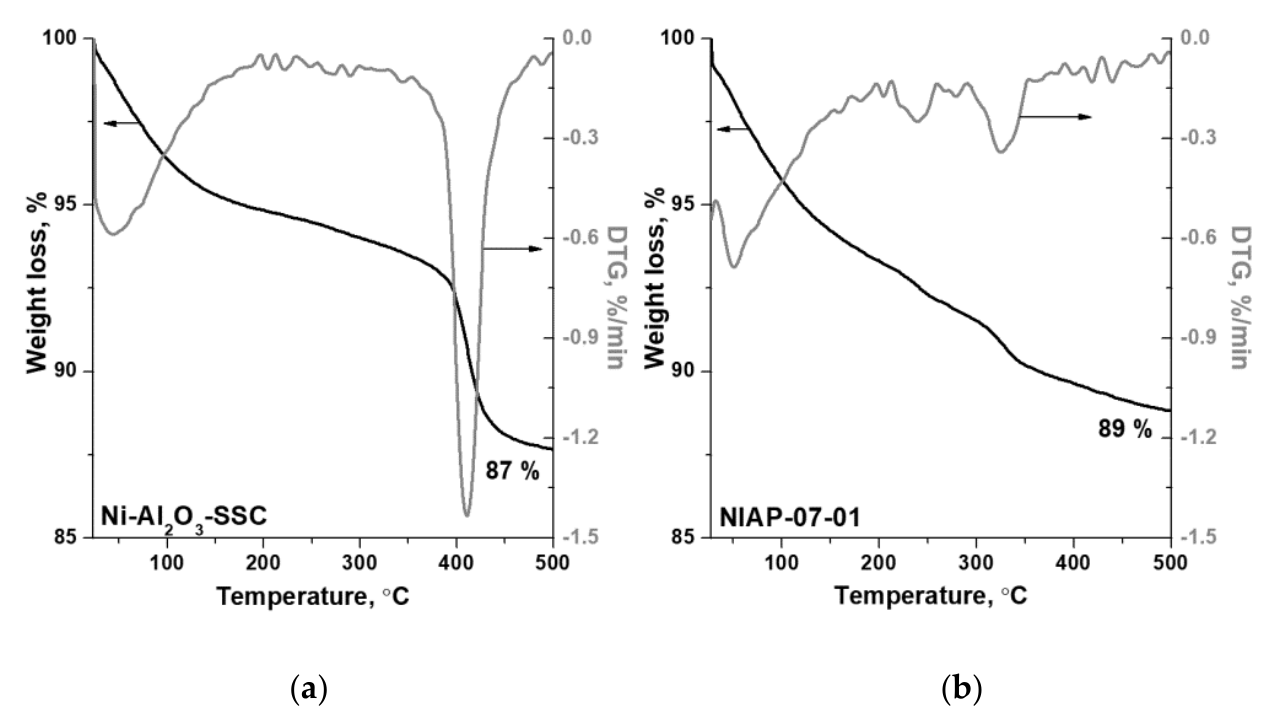
Figure 5. Thermal analysis data for ( a ) Ni-Al 2 O 3 -SSC and ( b ) NIAP-07-01 catalysts (helium, 10 ◦ C · min − 1 ). Besides, the low aluminum content (Table 1) can be associated with phase inhomo- geneity of catalysts, especially for an industrial NIAP-07-01 catalyst. Its XRD pattern contains an intense peak of graphite (at angle 26.5 ◦ ), as well as weak intensity peaks at low angles (2 θ = 20.4, 23.1 ◦ ), which could not be interpreted unambiguously. Moreover, for NIAP-07-01, there is an increase of spinel cell parameter of alumina (Table 2), probably due to the intercalation of nickel cations with a larger ionic radius than Al 3+ . Table 2. The phase composition of Ni-Al 2 O 3 -SSC and NIAP-07-01